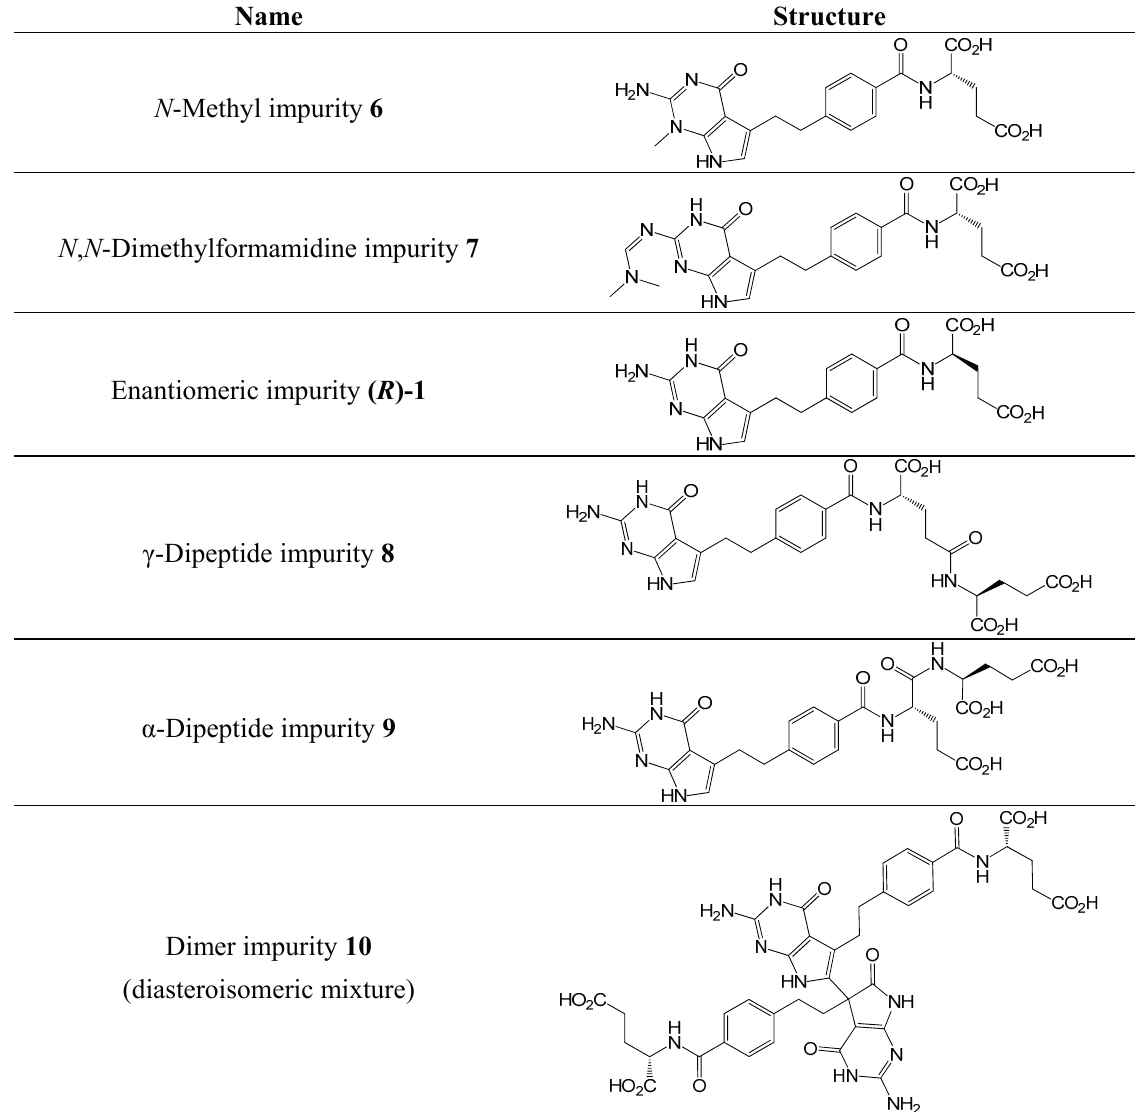
Table 1. Main impurities of